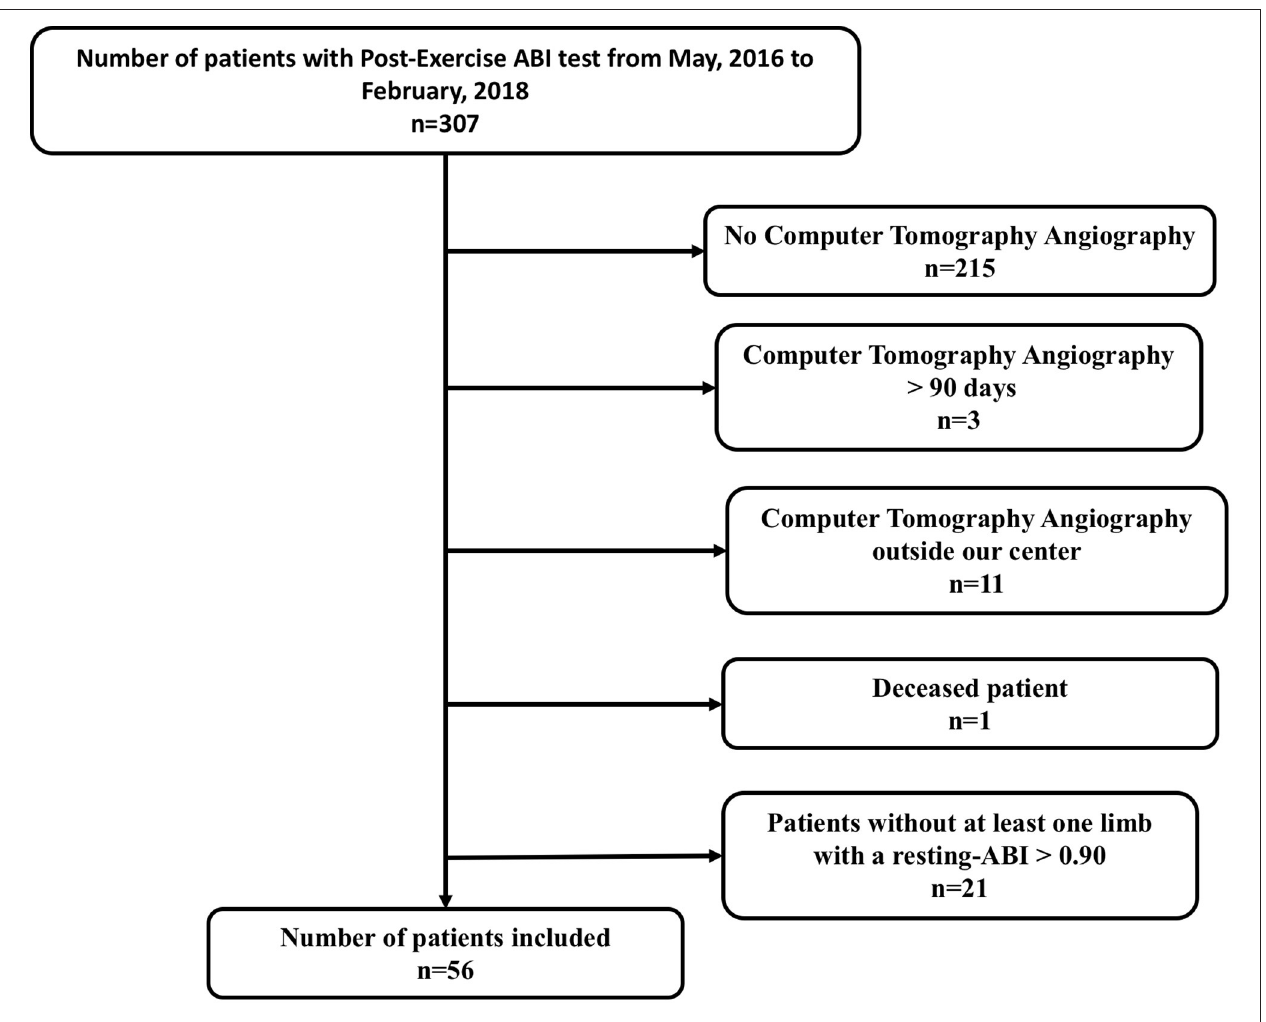
FIGURE 1 | Flow chart. ABI, Ankle-Brachial